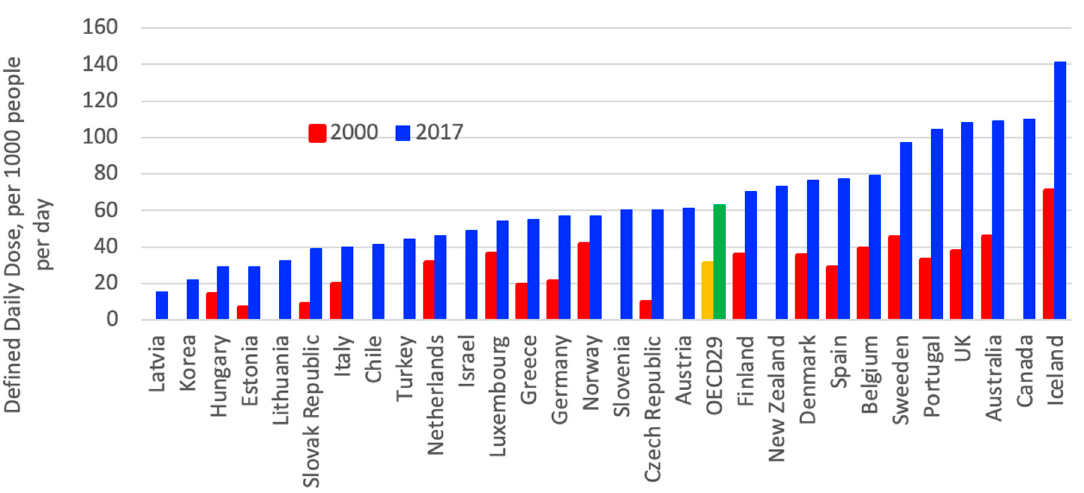
Figure 8. Consumption of antidepressant drugs in OECD countries between 2000 and 2015 [3]. Antihypertensive pharmaceutical consumption nearly doubled in OECD countries from 2000 to 2017, with the highest use occurring in Germany and Hungary at five times the consumption levels of Korea and Turkey (Figure 9). In Luxemburg and Estonia, the consumption levels have nearly quadrupled. These remarkable variations are a consequence of differences in the prevalence of high blood pressure and clinical practices [3].